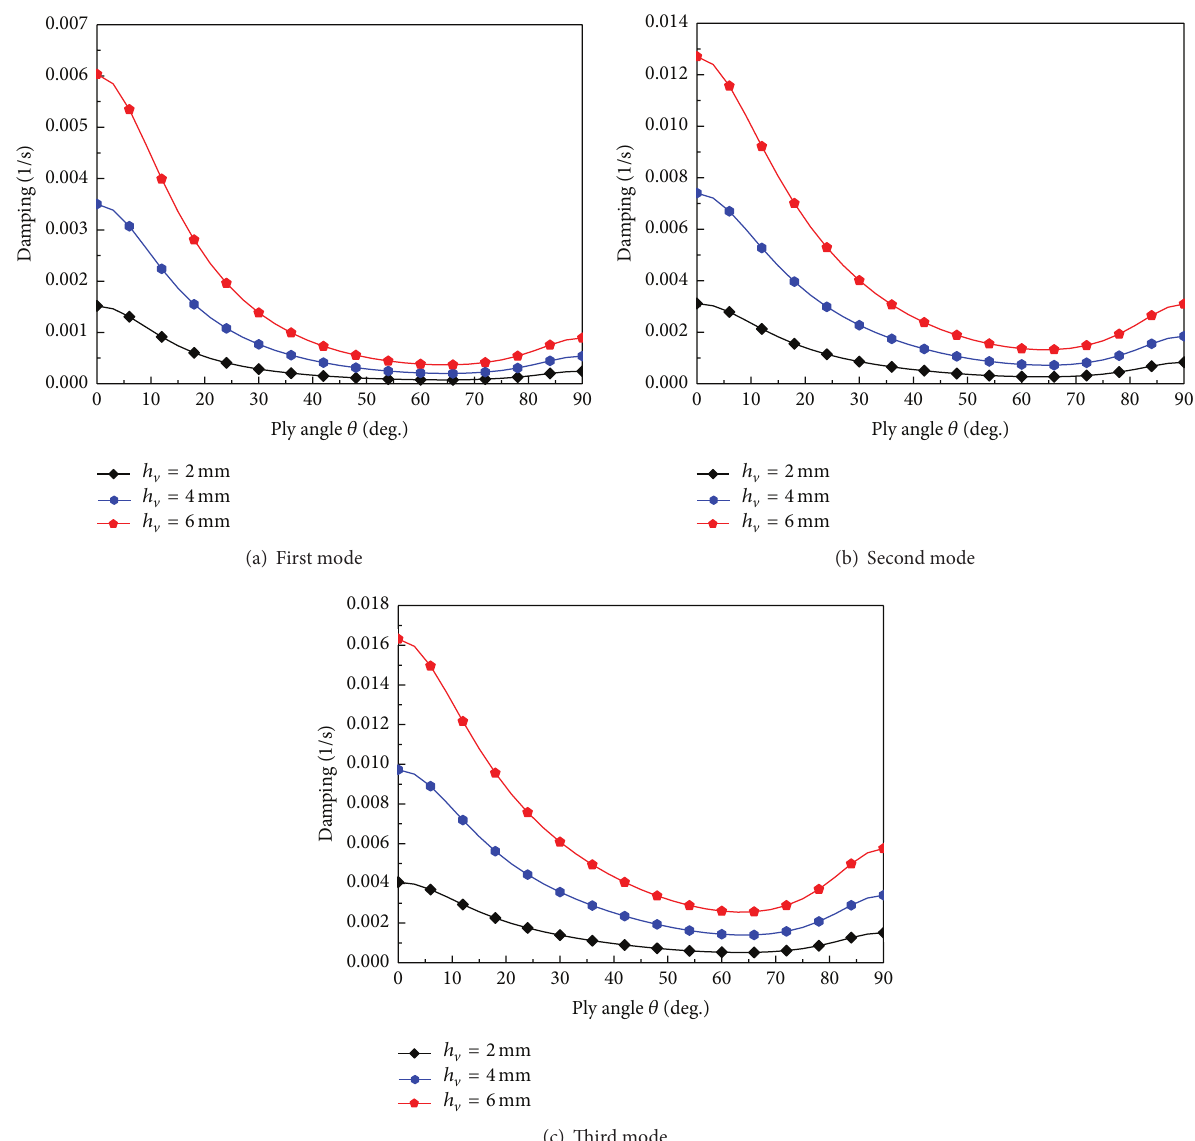
Figure 5: The first three dampings versus fiber angle for various thicknesses of viscoelastic damping layer ( ℎ 𝑐 = 2 mm, Ω =